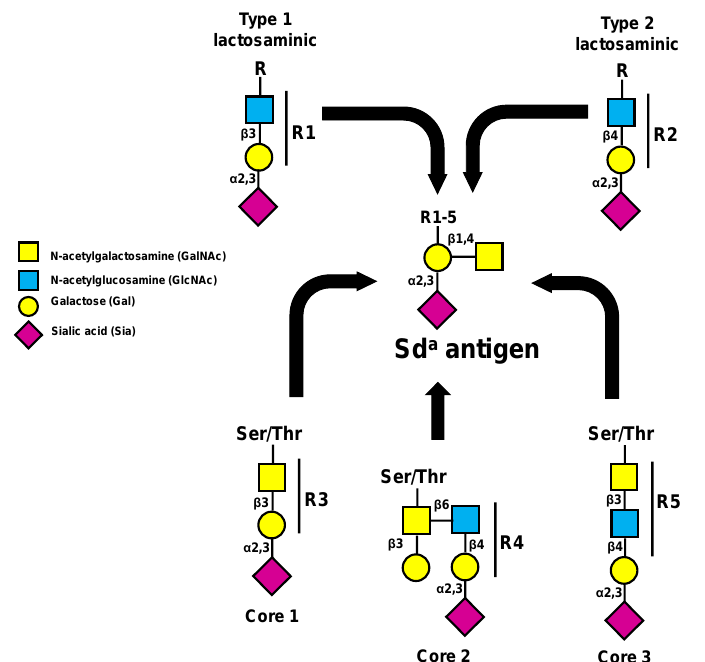
Figure 1. Structure of the different carbohydrate chains that can be terminated by the Sd a antigen. These structures can be present on N- or O-linked chains. The addition of β 1,4-linked GalNAc is always mediated by B4GALNT2.